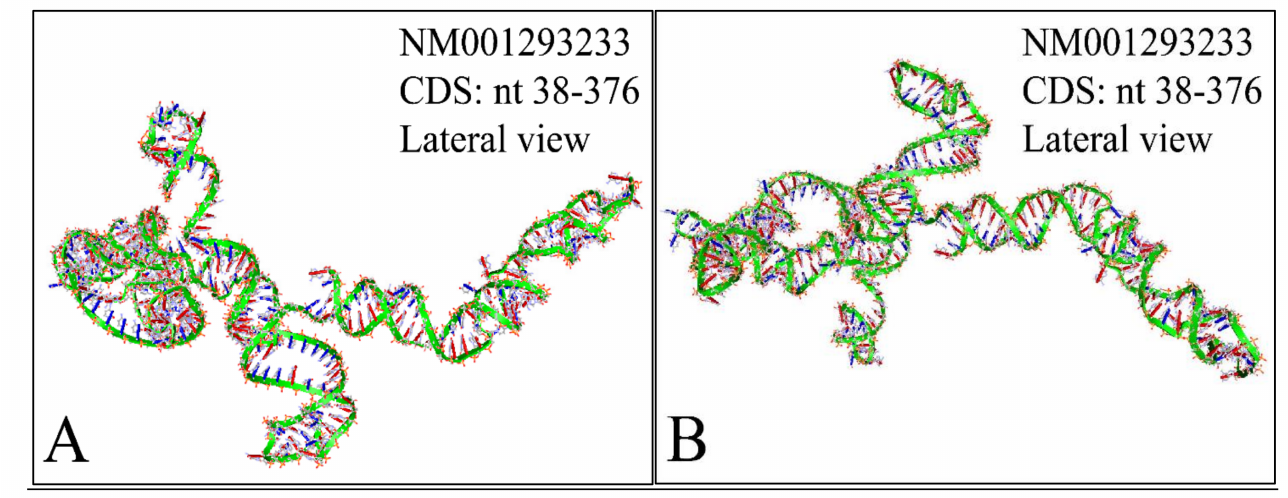
Figure 13. The predicted 3D structure of the MYCN , NM001293233 CDS region (nucleotides 38–376). The proximal ( A ) and the distal ( B ) lateral views are presented (3D structure was predicted using the RNAcomposer web-tool [87,88] and it was then visualized using the Accelrys Discovery